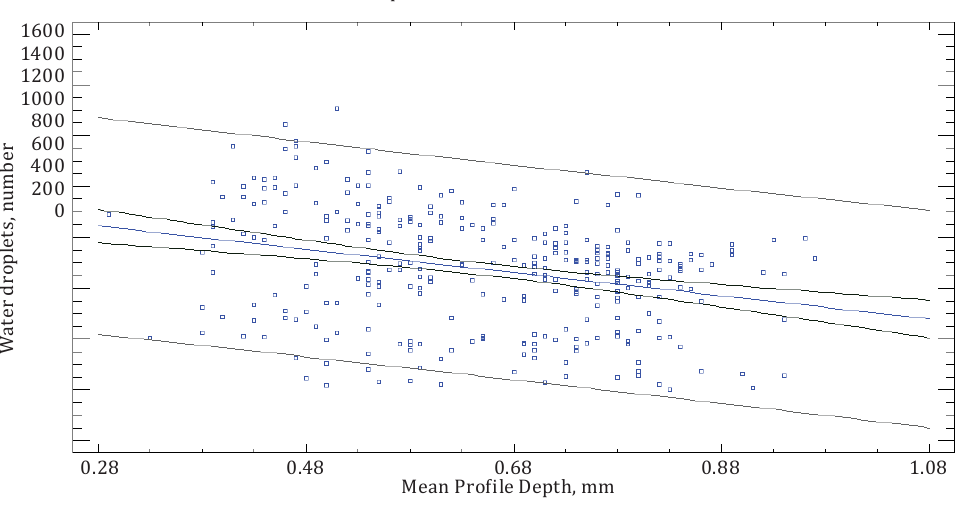
Figure 10. Number of water droplets on Test Track 3